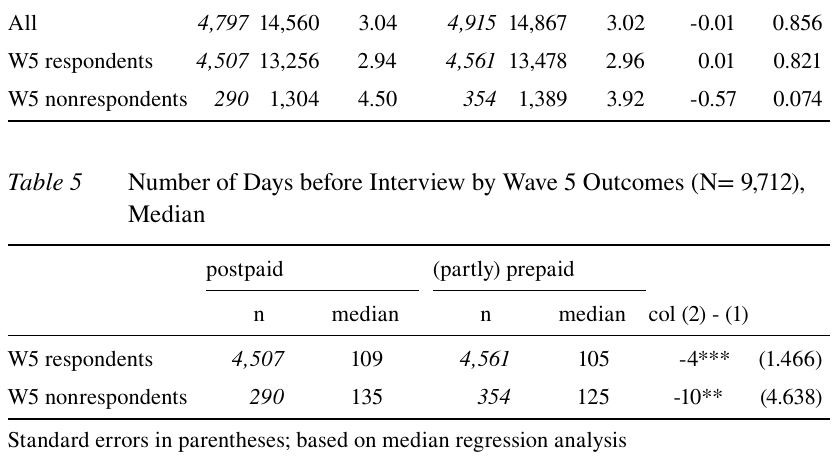
Number of Contact Attempts before Interview by Wave 5 Outcomes (N= 9,712) postpaid (partly) prepaid Contact Contact attempts attempts (average) n